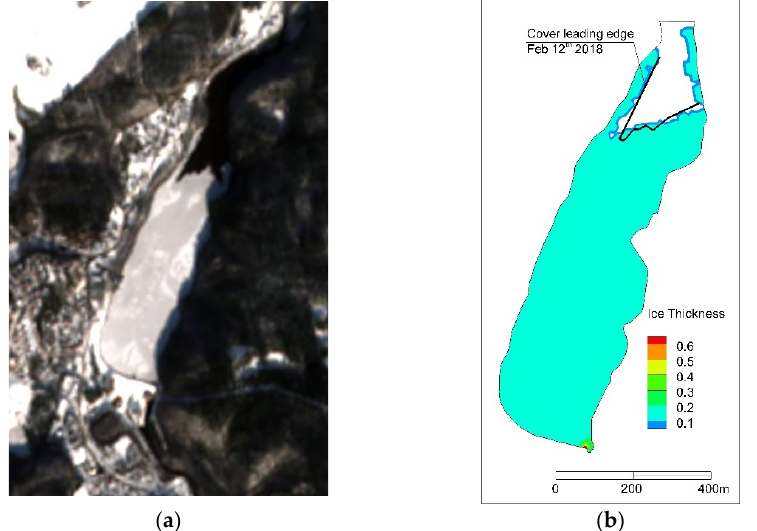
Figure 6. Comparison of the ( a ) satellite image of 12 Feb 2018. Sentinel-2. ( b ) Results of the numerical simulation, ice distribution in the Łapino reservoir under the conditions of the north wind with a speed of 13 m/s (high wind).